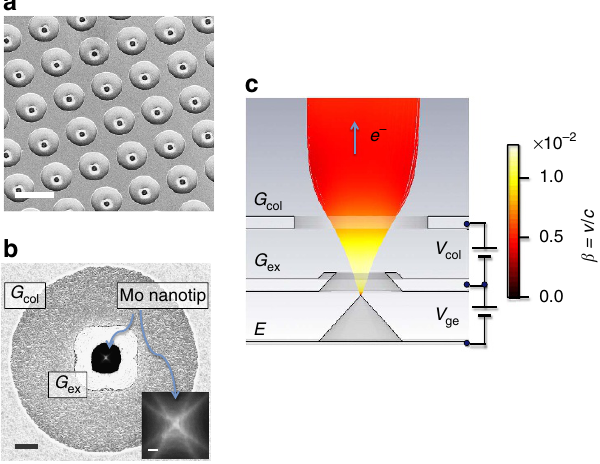
Figure 1 | Double-gate FEA. ( a ) Scanning electron microscopic (SEM) images of the fabricated double-gate Mo nanotip array cathode (bird’s eye view). The scale bar is 10 m m. ( b ) Magnified SEM image of one emitter (top view). The scale bar (black) shows 1 m m. The inset is the top-view high- magnification image of one of the nanotip apex (the scale bar is equal to 20nm). ( c ) Schematic cross-section of single emitter. The electron pulses are generated by the electron extraction potential V ge ( 4 0) and collimated by the collimation potential V col ( o 0). G ex : electron extraction gate, G col : beam collimation gate, E : emitter substrate. The electron trajectories at the collimation condition simulated at the external acceleration field of 2.5MVm (cid:2) 1 are also shown. The colour code indicates the electron velocity b ( ¼ v / c , where c is the speed of light). The electron trajectories were calculated by a particle-tracking simulator (CST particle